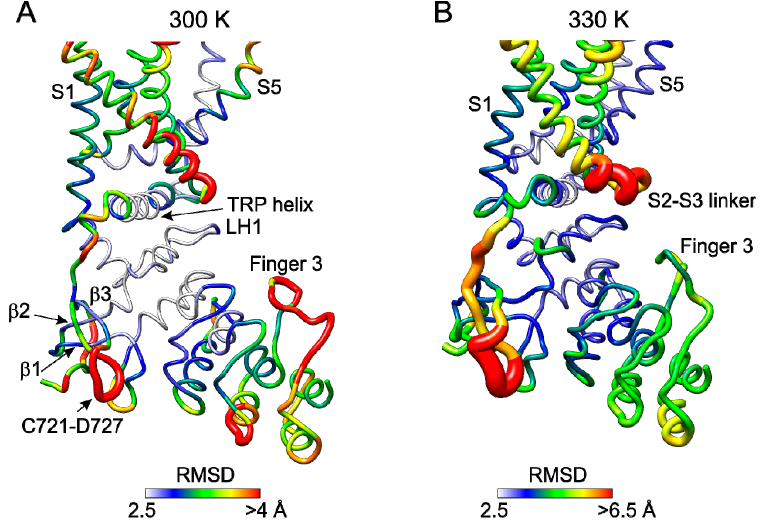
Figure 8. Molecular flexibility of TRPV3 at 300 and 330 K. ( A , B ) Results from 50-ns MD simulations of the closed-state TRPV3 structure ( PDB ID: 6DVW ) at 300 K (~27 °C, A) and 330 K (~57 °C, B). The RMSD values calculated for the backbone atoms are shown for one monomer (chain A). The most flexible residues are colored red (RMSD >4 Å at 300 K and >6.5 Å at 330 K), intermediately flexible yellow-to-green (>3.2 Å and >4.5 Å) and the least flexible blue-to-white (<2.9 Å and <3.5 Å). The worm radius is proportional to RMSD (2–8 Å at 300 K and 2–10 Å at 330 K).